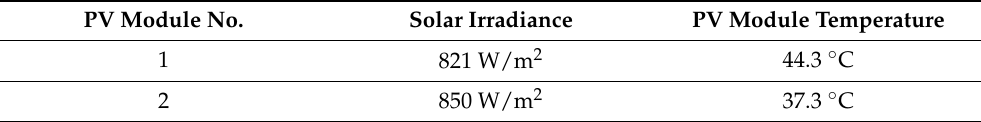
Table 10. PV module 2 (washed) I-V curve test